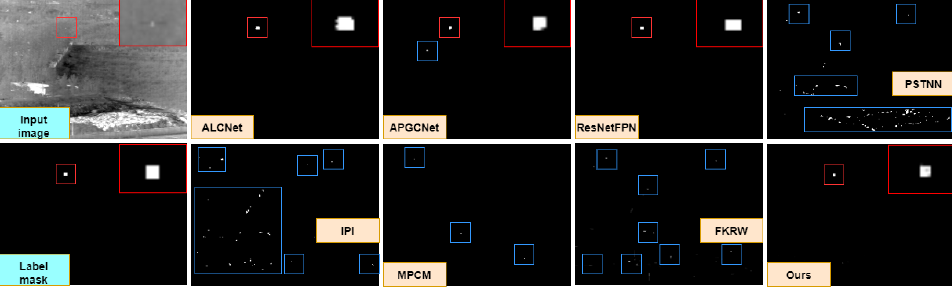
Figure 13. Detection results of infrared small targets in Scene 6 using different detection methods.